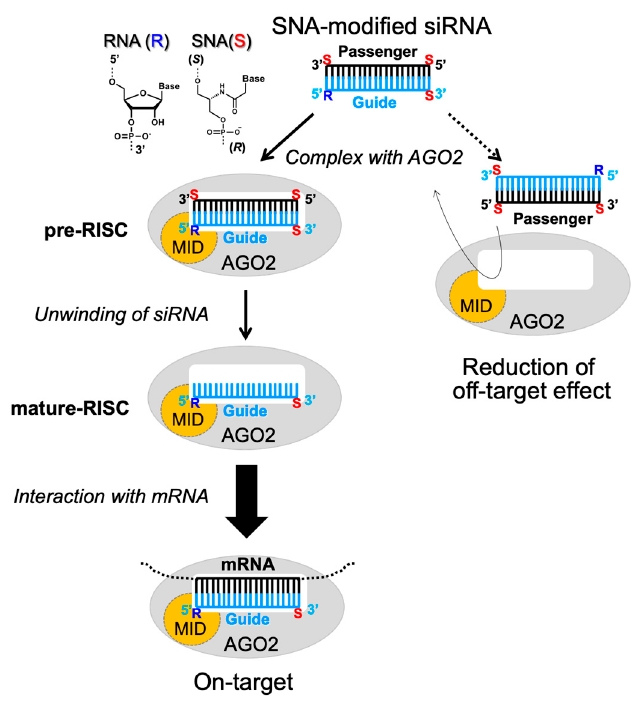
Figure 1. Schematic illustration of the proposed mechanism, by which serinol nucleic acid (SNA)-substituted small interfering RNA (siRNA) reduces off-target activity. In pre-RNA-induced silencing complex (pre-RISC), an interaction between the 5’ terminus of one strand and the MID domain results in selection of that strand for the formation of RISC. Off-target effects can occur if the passenger strand is selected. The presence of the SNA moiety at the 5’ terminus of the passenger strand inhibits the interaction with Argonaute 2 (AGO2)-MID, reducing off-target effects.